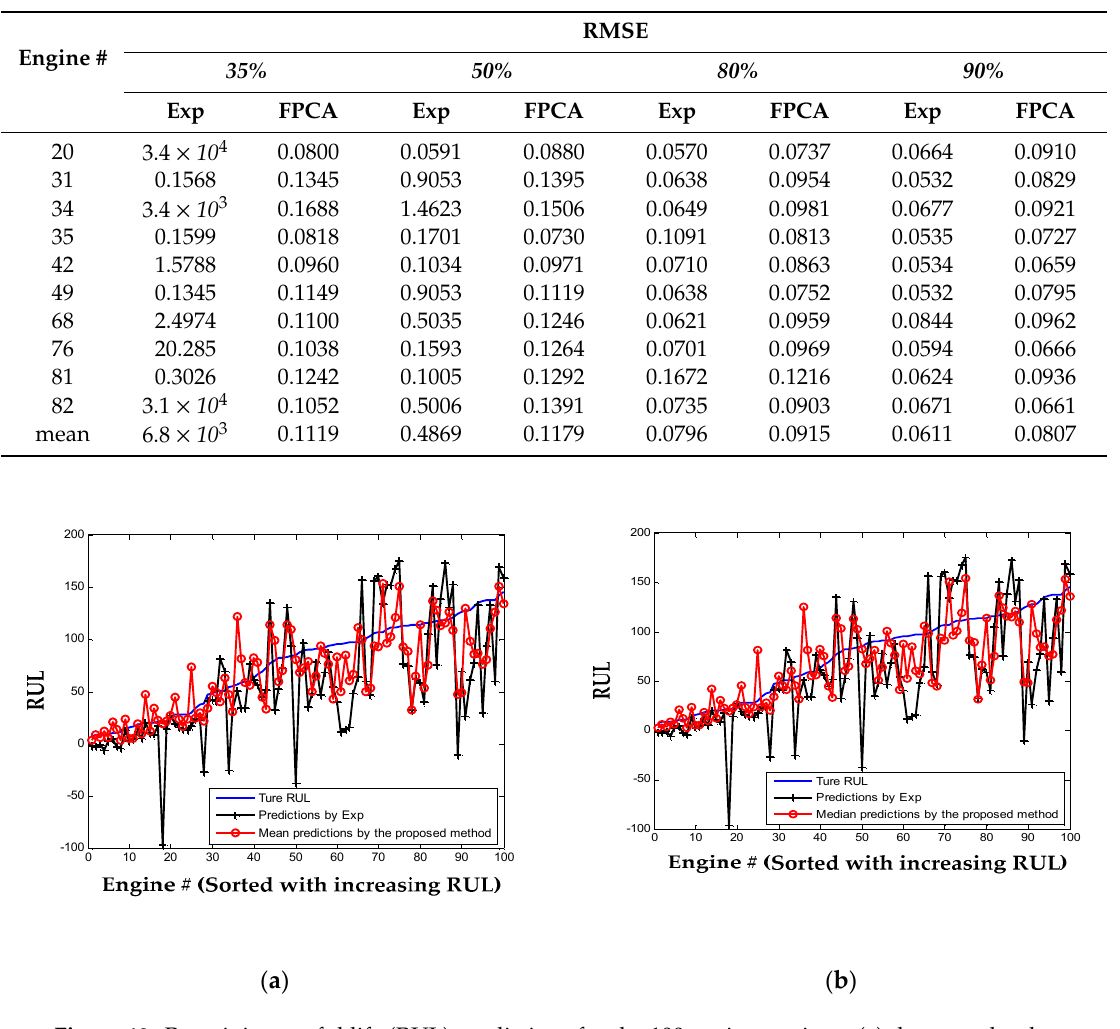
19 of 22 Table 5. Comparison of health prognostic results for the 10 testing engines. Engine #